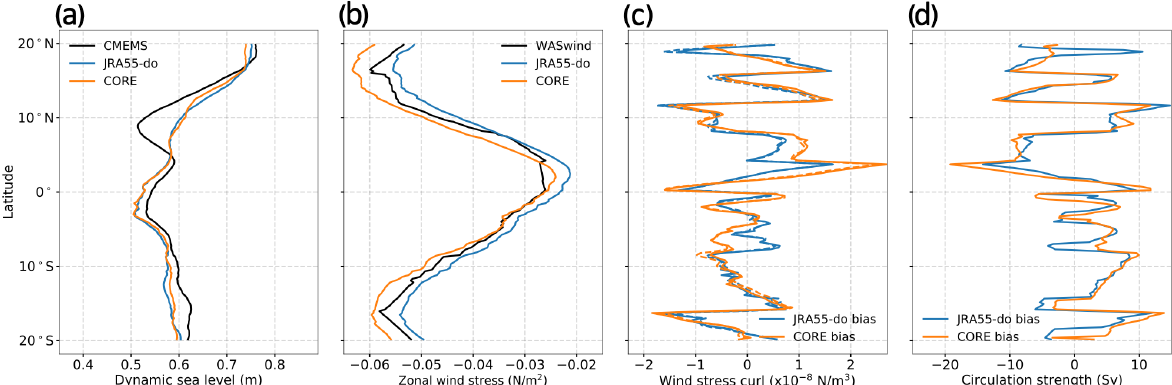
Figure 4. Figures show the zonal mean profile of (a) DSL from CMEMS and OMIP simulations (JRA55-do and CORE), (b) zonal wind stress from WASwind and OMIP forcing data (JRA55-do and CORE), (c) wind stress curl bias (solid) and zonal-wind-induced wind stress curl bias (dashed) for the simulations, and (d) the bias of circulation strength defined as the maximum value of the Sverdrup stream function for the simulations along each latitude over the tropical Pacific.